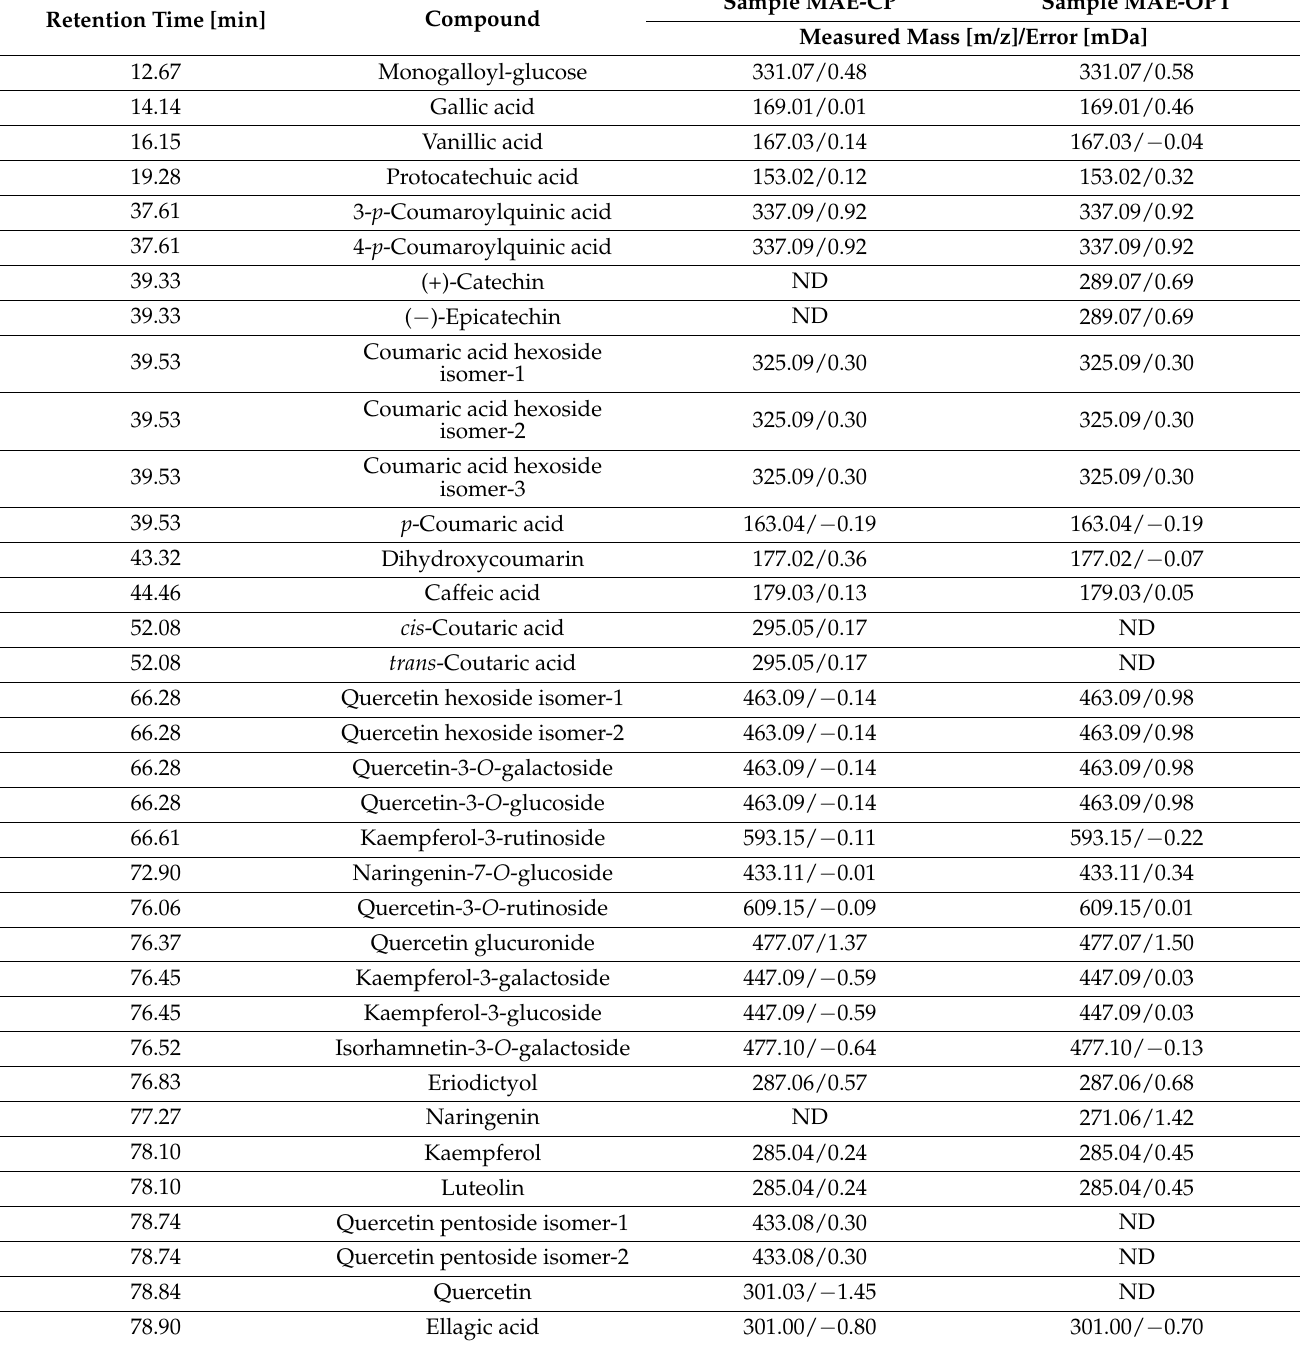
Table 6. Polyphenols profile of extracts obtained on the central point (Sample MAE-CP) and under the optimal conditions (Sample